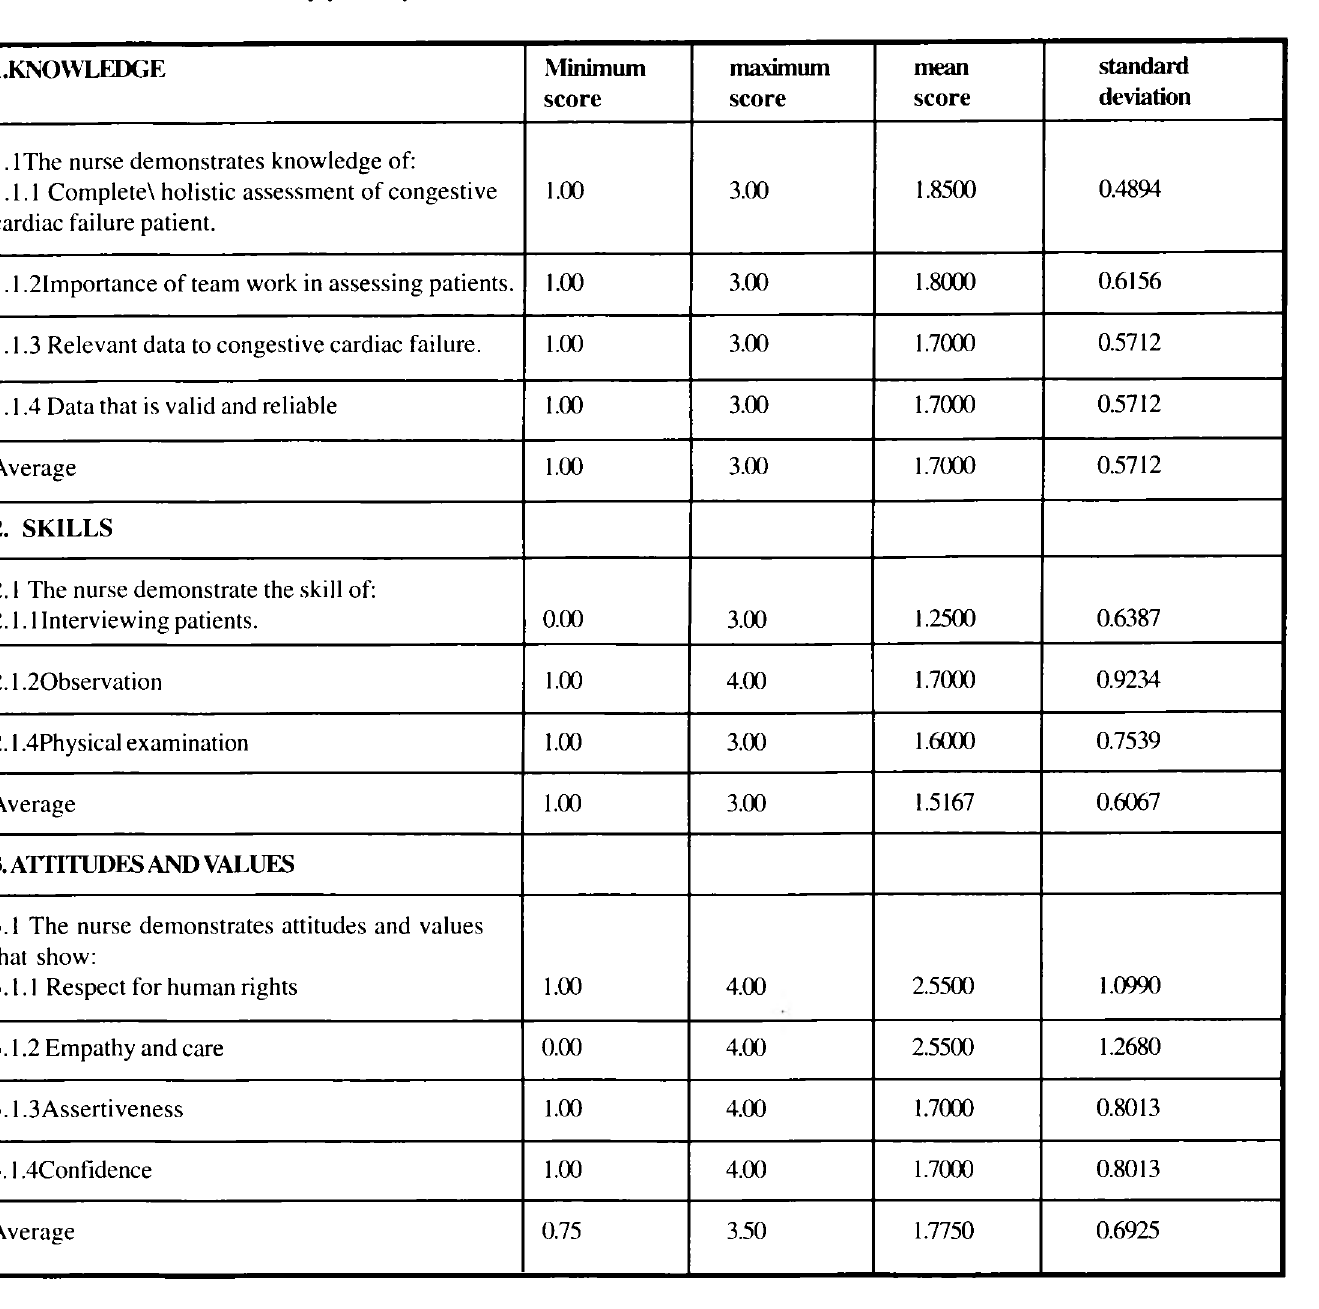
Table 1.2 Scores obtained by participants on